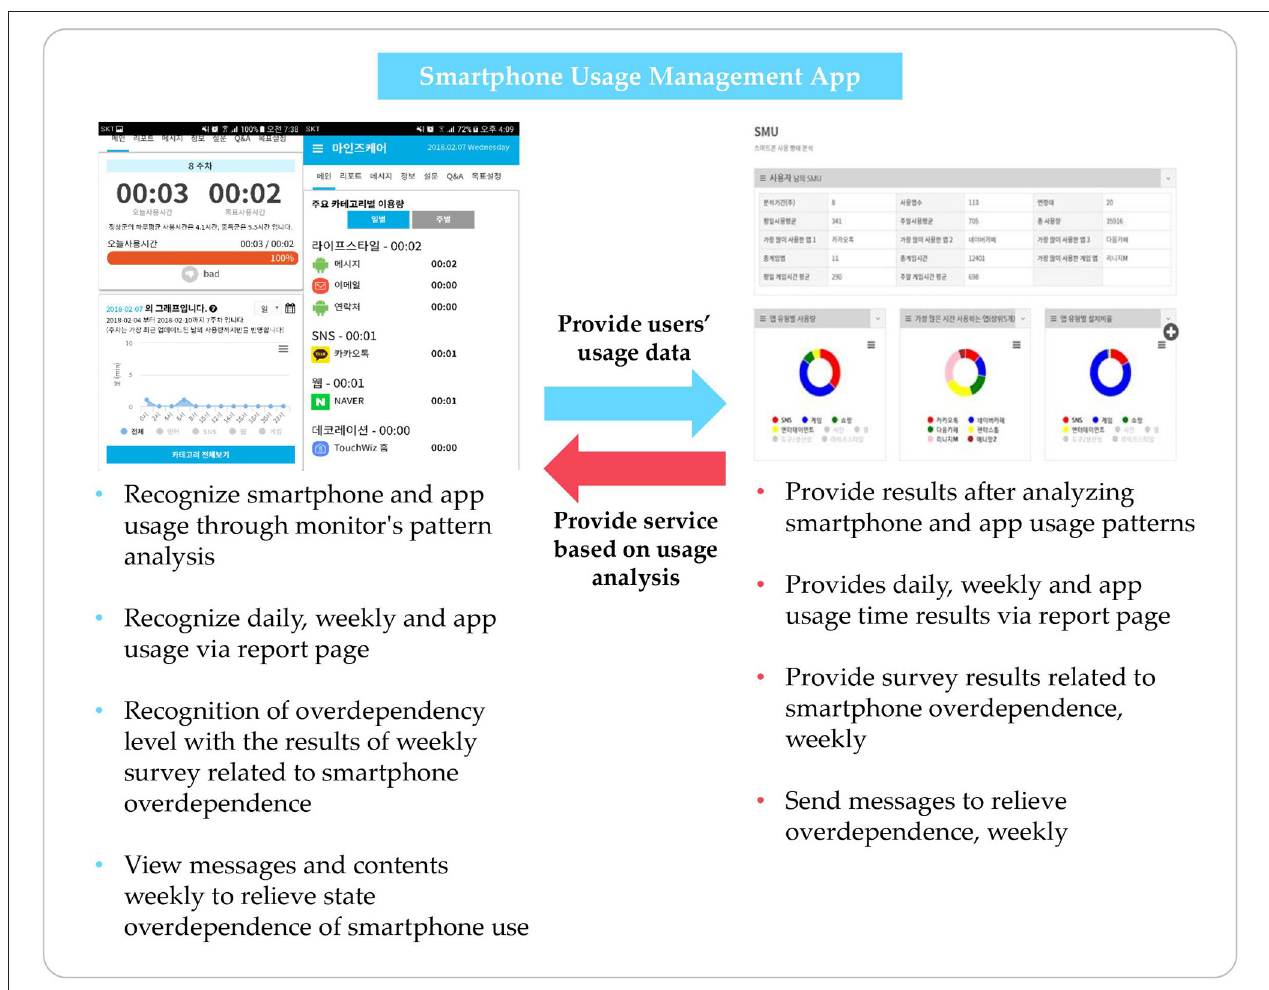
FIGURE 2 | Description of developed